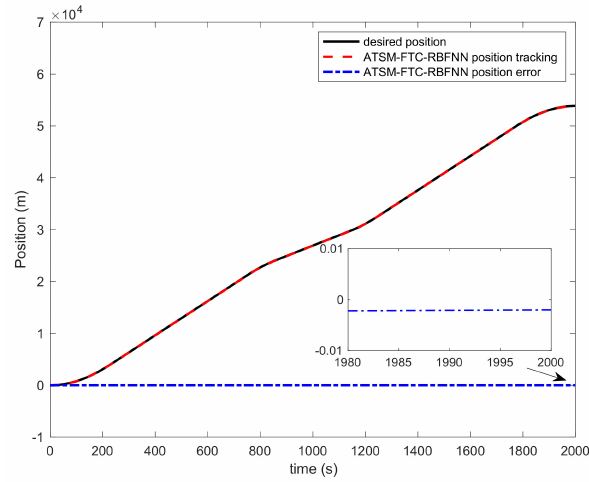
Figure 4. Position tracking performance ATSM-FTC-RBFNN.